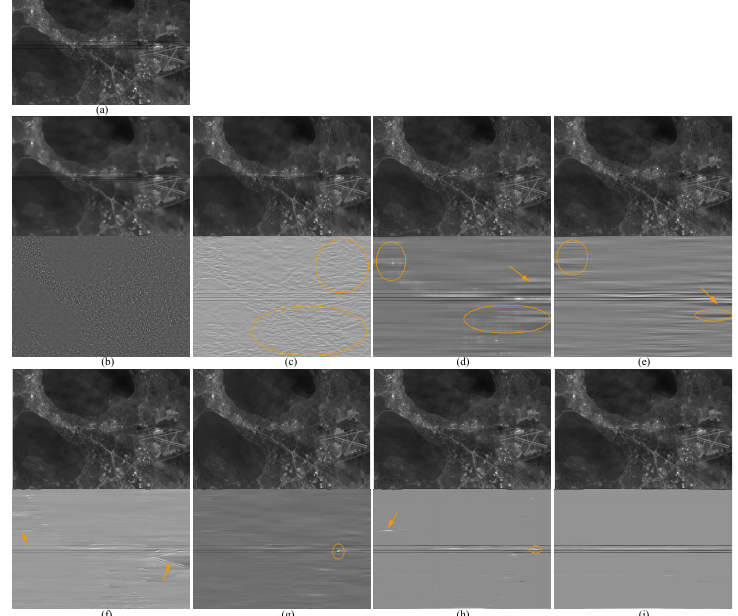
Figure 21. Results of different methods on Hyperion data band 35 R5. ( a ) original; ( b ) BM3D; ( c ) SNRCNN; ( d ) GF-based; ( e ) WAFT; ( f ) UV; ( g ) HUTV; ( h ) SUV; ( i ) WDSUV. In each result, the top part is the destriping result, and the bottom part is the corresponding stripe noise estimation.